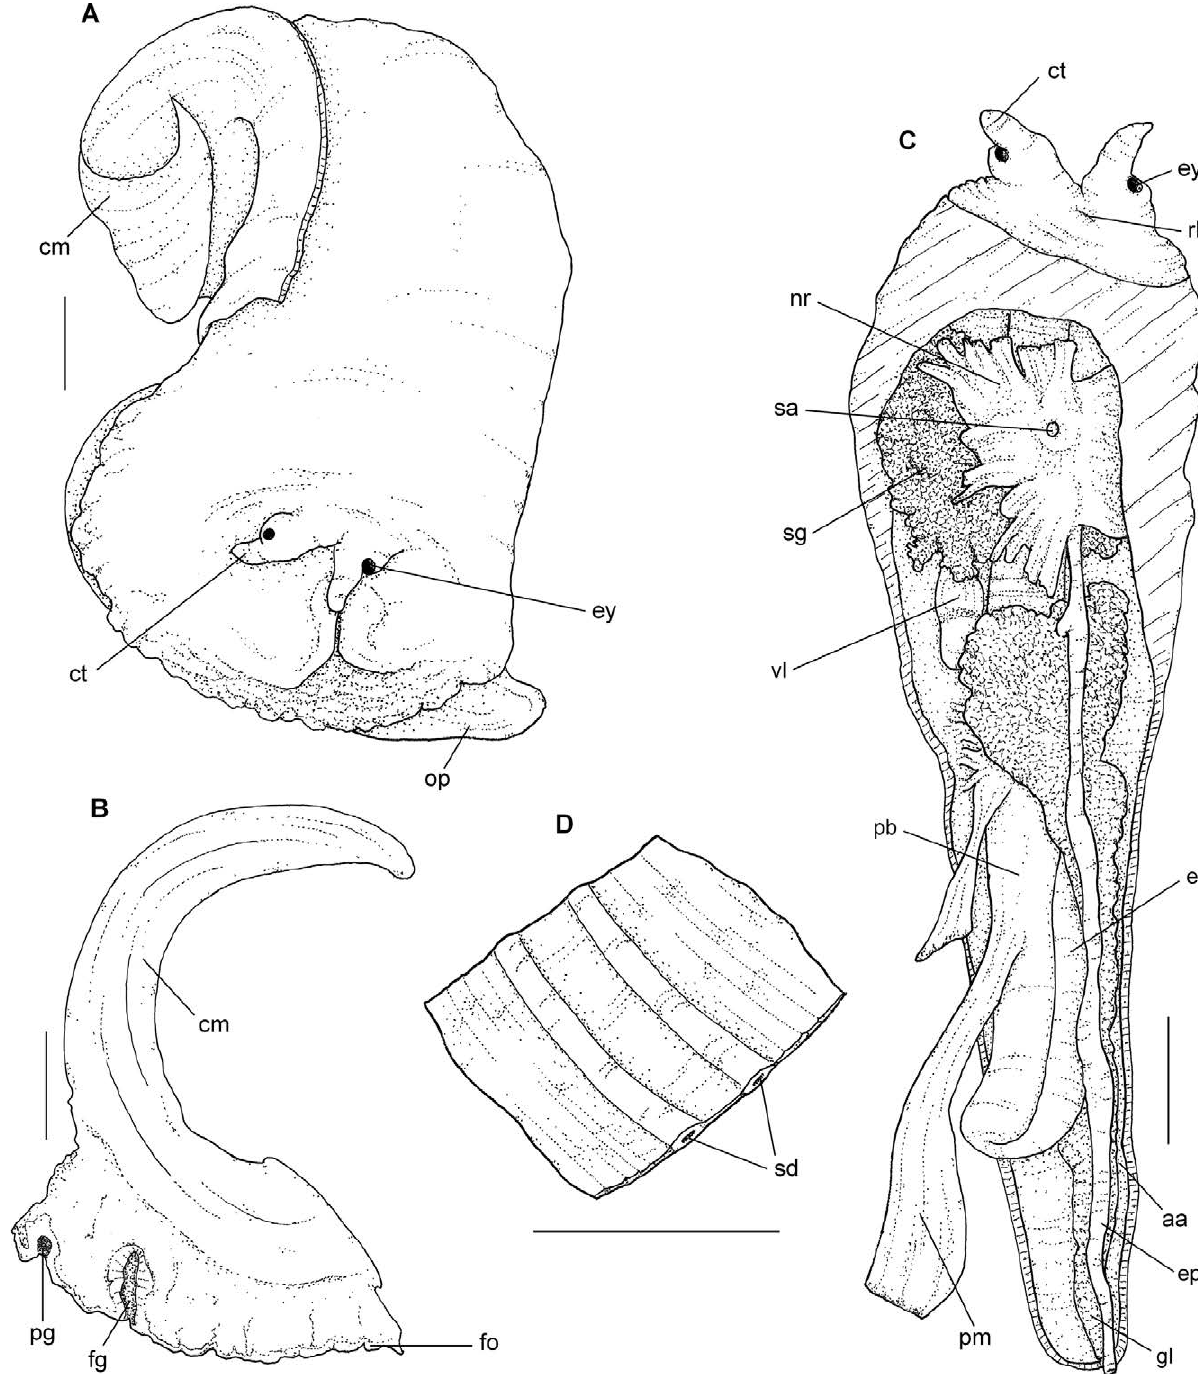
Fig. 7. – Hemipolygona beckyae . A, head-foot mass in dorsal view; B, longitudinal section of head-foot mass, female; C, haemocoel in ventral view; D, lumen of anterior esophagus. Abbreviations: aa, anterior aorta; cm, columellar muscle; ct, cephalic tentacle; ea, anterior esophagus; ep, posterior esophagus; ey, eye; fg, female cement gland; fo, foot; gl, gland of Leiblein; nr, nerve ring; op, operculum; pb, proboscis; pg, pedal gland; rh, rhynchostoma; sa, statocyst; sd, salivary gland duct; sg, salivary gland. Scale bars: A-C, 2 mm; D, 0.5